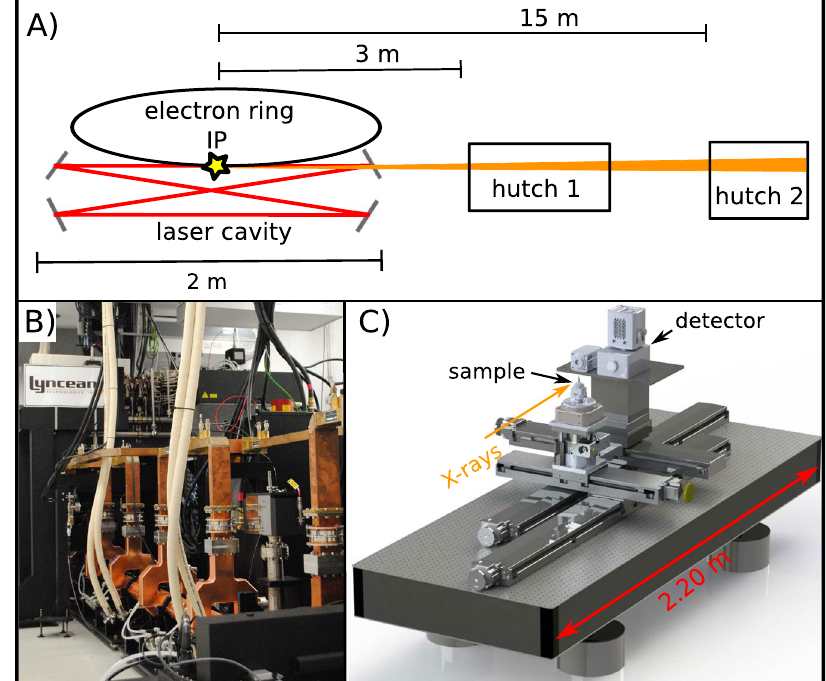
Figure 1. ( A ) Schematic of the Munich Compact Light Source (MuCLS) facility. The facility consists of three main parts. The first one is the production of the X-rays, the second and third are the experimental hutches 1 and 2 placed downstream of the interaction point (IP) of the electron and laser beam. ( B ) Electron accelerator of the MuCLS machine. ( C ) CAD-view of the setup located in hutch